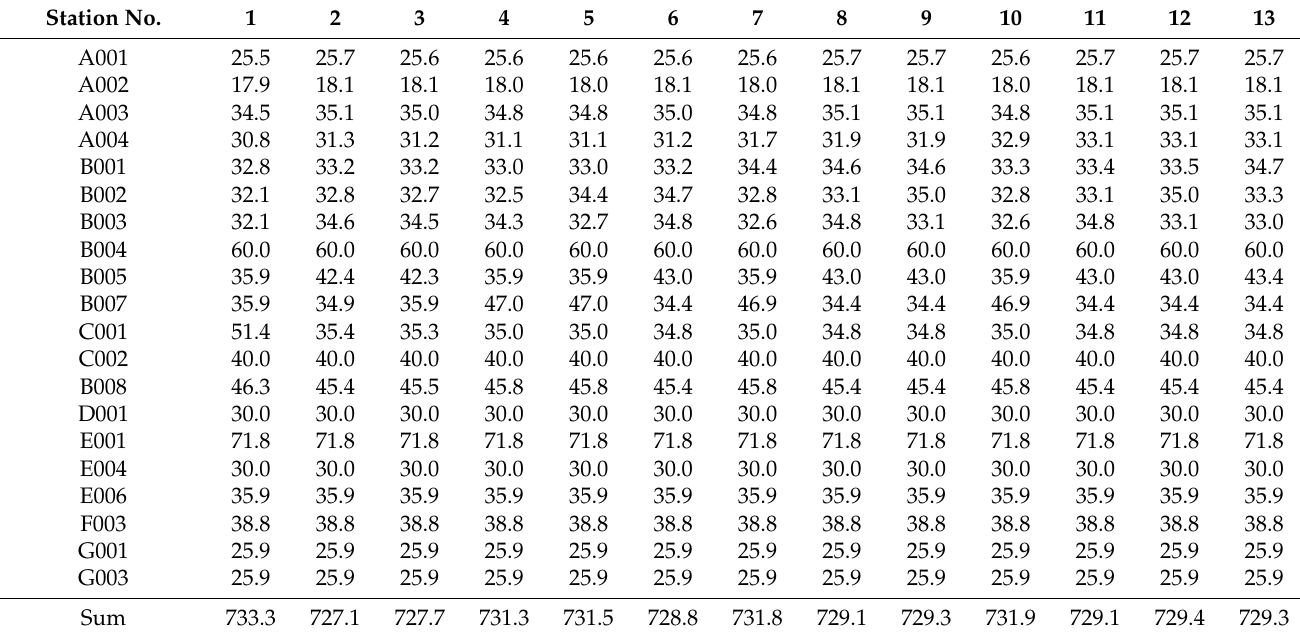
Table 10. Shaft power of compressor stations for different schemes.